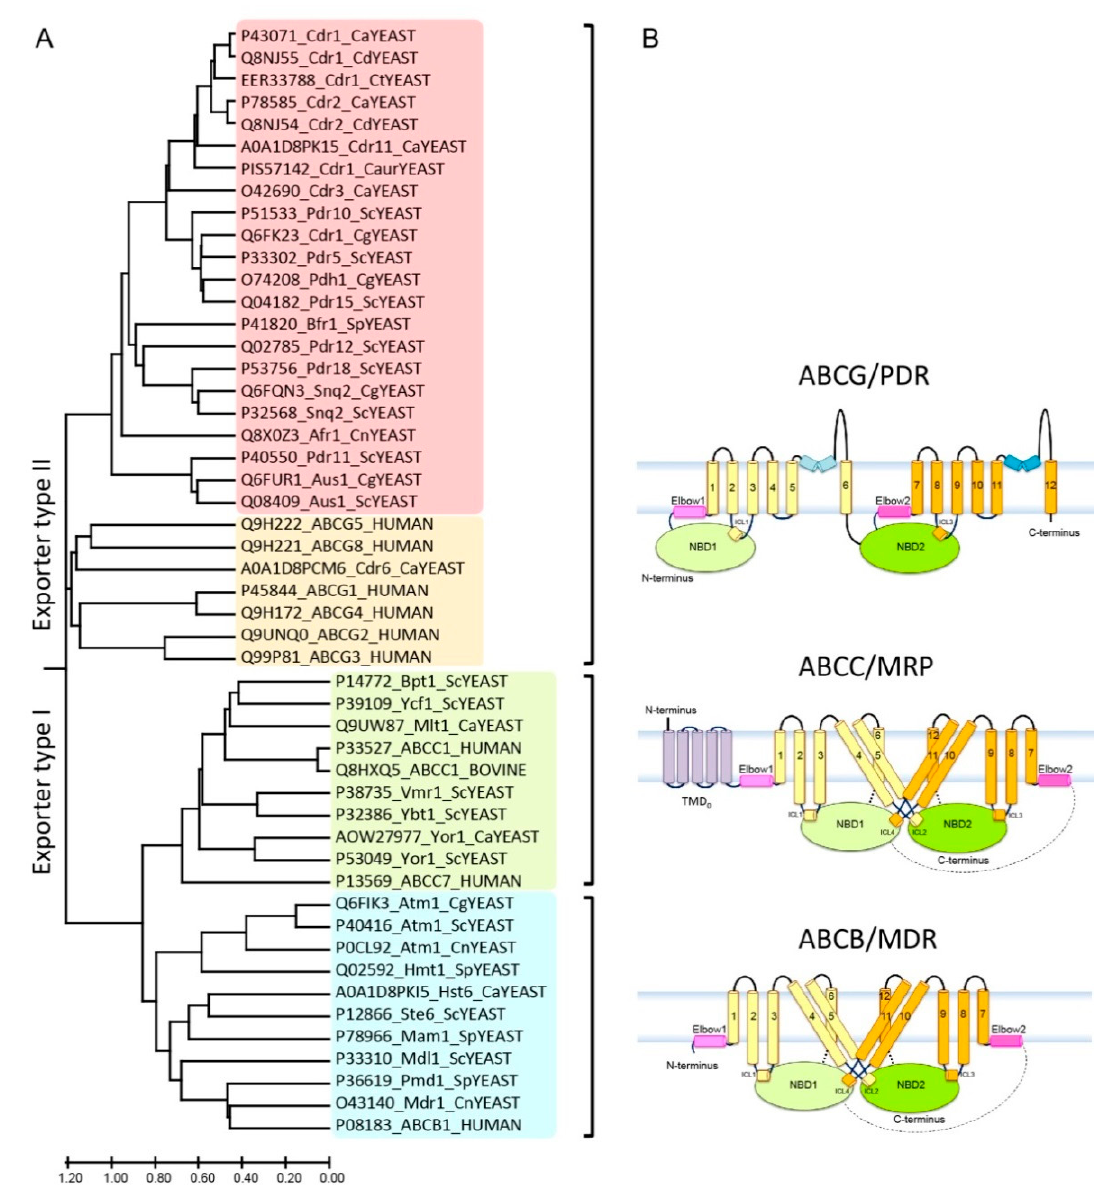
Figure 1. Phylogeny and structural organization of ABC transporters in mammals and yeast. ( A ) The phylogenetic tree shows the evolutionary relationships of ABC transporter subfamilies in yeast and mammals. Some 29 ABC transporters were subjected to amino acid sequence alignments. Branch length was analyzed using MEGA-X, and represents the evolutionary distance in the units of the number of amino acid substitutions per site. Names are given in the UniProt code, protein name and organism, respectively. The analysis reveals two major exporters subfamilies referred to as type I and II. Type I was sub-classified into ABCB/MDR (blue) and ABCC/MRP (green) subgroups. The type II family represents ABCG/PDR subgroups with the fungal (red) and mammalian transporters (orange). Ca: Candida albicans , Cg: Candida glabrata , Caur: Candida auris , Cd: Candida dubliniensis , Ct: Candida tropicalis , Cn: Cryptococcus neoformans , Sc: Saccharomyces cerevisiae , Sp: Schizosaccharomyces pombe . ( B ) Predicted membrane topologies of three MDR ABC exporter families. The transporters hold several diagnostic hallmark domains, including two NBDs (NBD1: light green; NBD2: green), two TMD regions usually with 6 putative membrane-spanning helices each (TMD1: light yellow; TMD2: bright orange), elbow helix (pink), re-entry helix (blue) and TMD0 (purple), respectively.